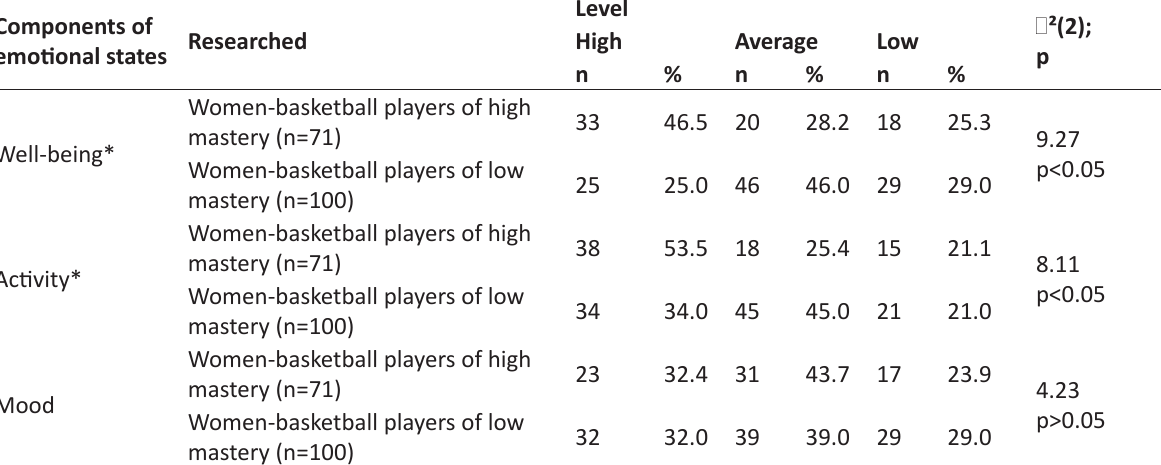
Table 1. Distribution of pre-competition emotional state indexes of women-basketball players of different mastery (in numbers and per cent) Components of Researched emotional states